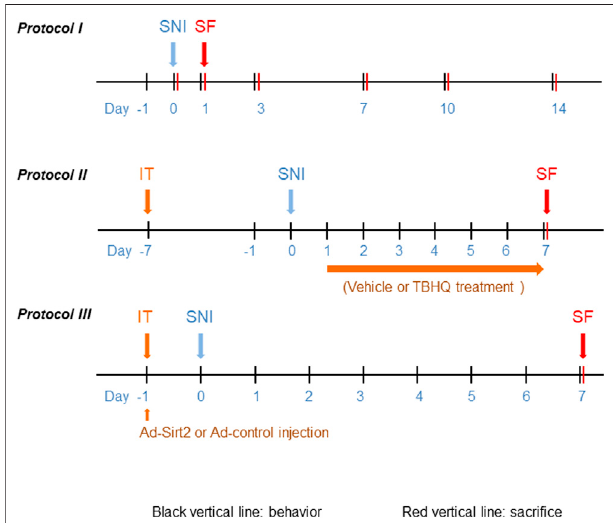
FIGURE 1 | Schematic illustration of the experimental protocols. SNI: spared nerve injury; IT: implantation of lumbar intrathecal catheter; SF: sacri fi